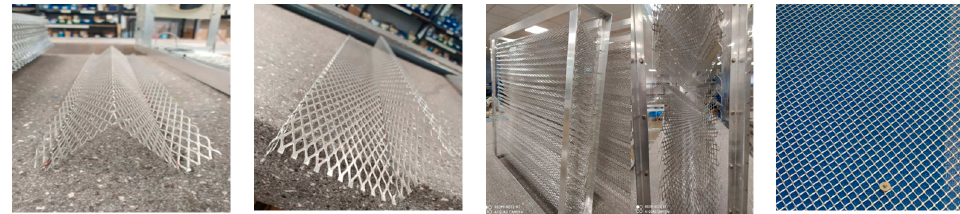
Figure 17. Example of different testing metal mesh.